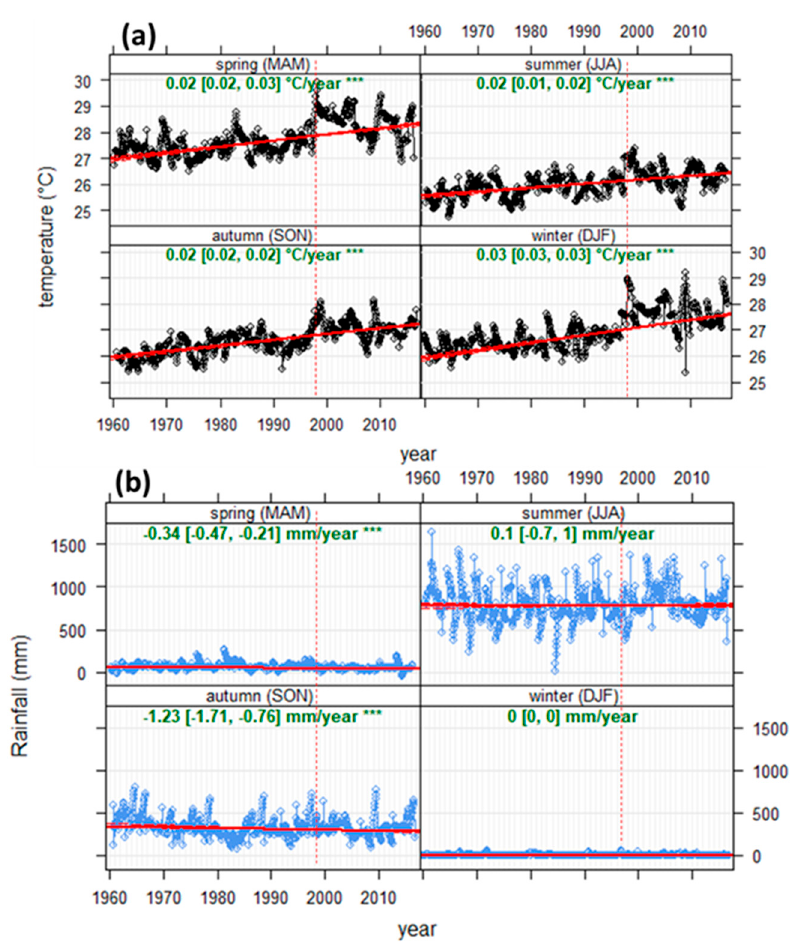
Figure 10. The plot shows the Seasonal trend distribution of monthly mean temperature ( a ) and rainfall ( b ) obtained with Theil-Sen’s estimate. The solid red line shows the trend estimate and the dashed red lines show the 95% confidence intervals for the trend based on resampling methods. The vertical red line indicate year 1998. There is no trend in rainfall during winter (0 mm per year).